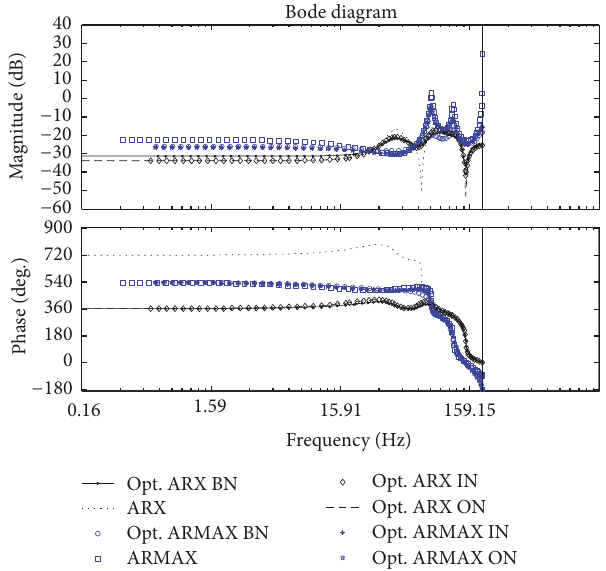
Figure9:BodeplotforARX(black)andARMAX(blue)realization; flow coefficient = 0.51. Data is filtered and resampled prior to system